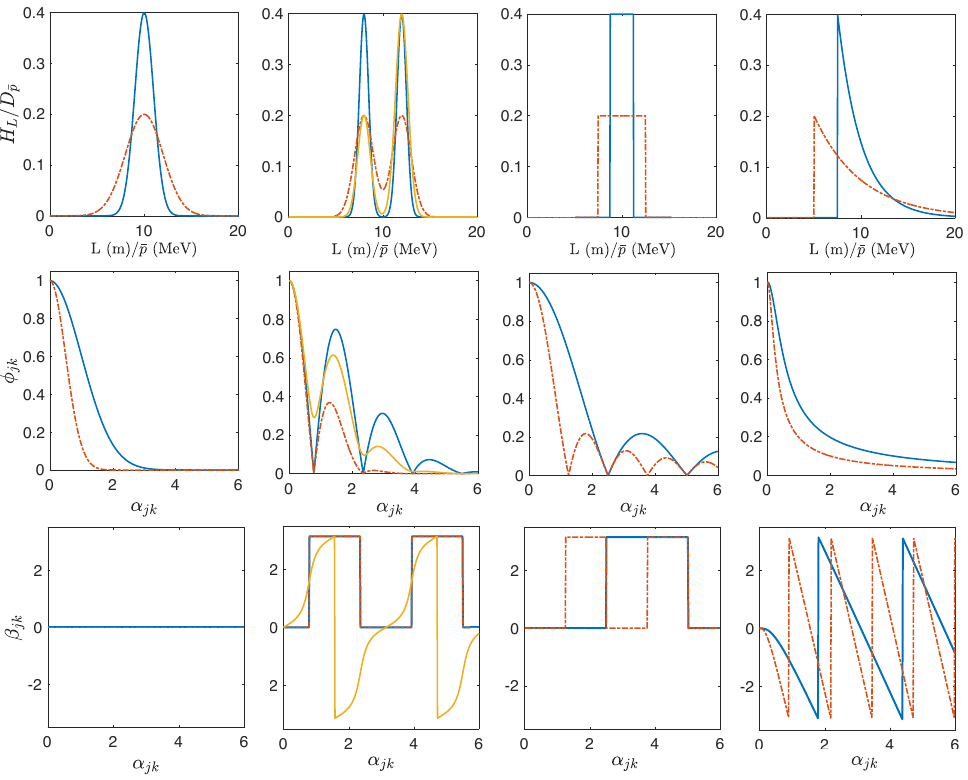
Figure 10 . Decoherence damping terms (second row) and phase shift terms (third row) for different shaped weighting functions (first row) of H both types of decoherence are described by Fourier transformation, the former transfers from L space to the α = ∆ m 2 / (2 E 0 ) corresponding to eq. (3.30); and the later from ¯ p to α jk = ∆ m 2 jk jk relates to eq. (3.25). In particular, the same coloured lines represent weighting functions with the same